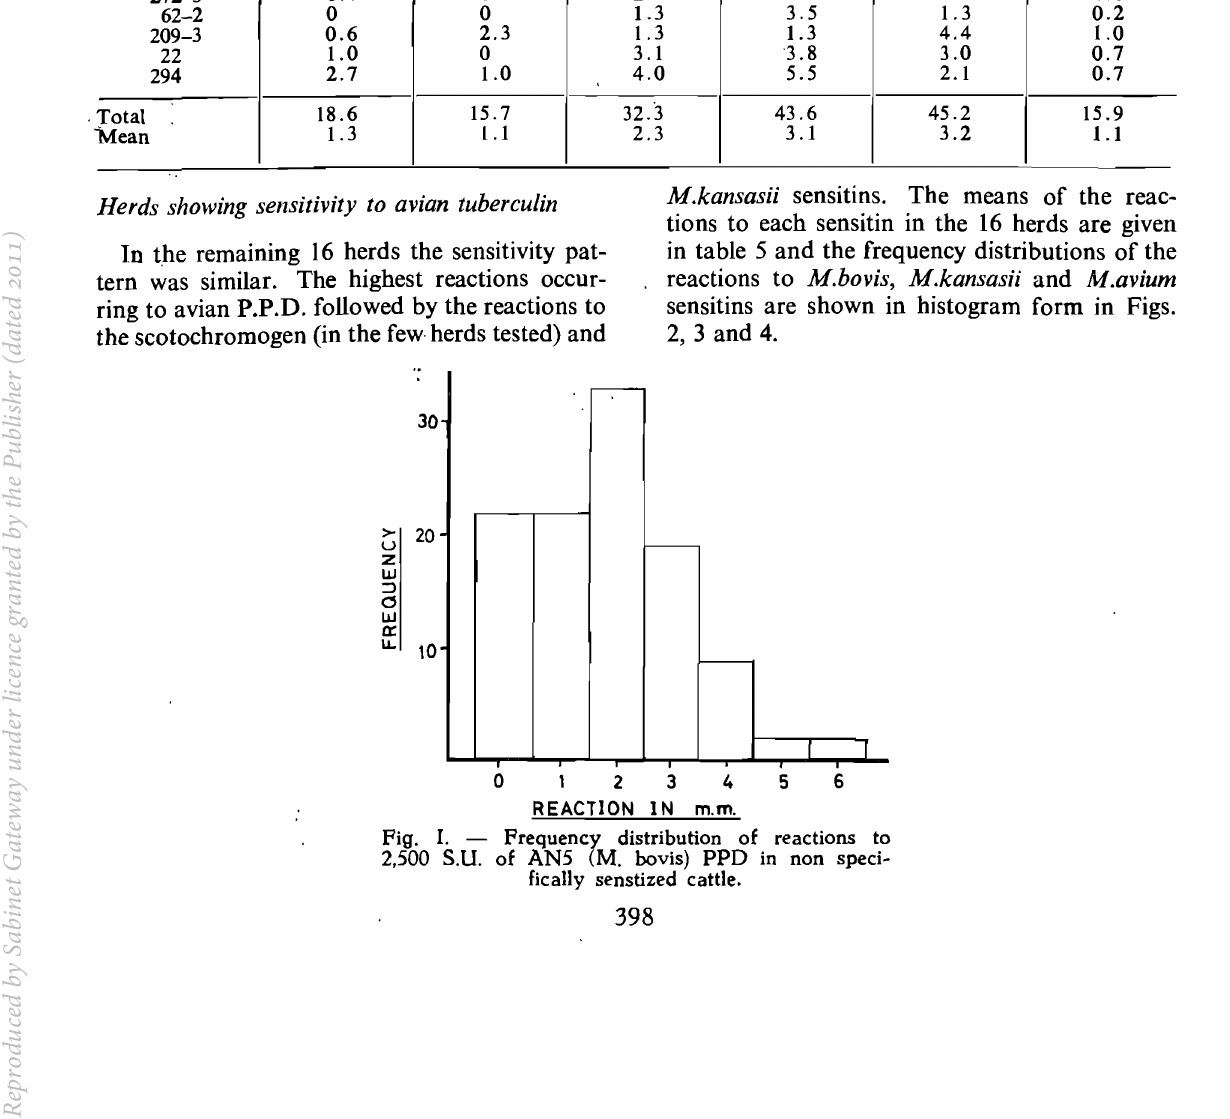
Frequency distribution of reactions to 2,500 S.U. of AN5 (M. bovis) PPD in non speci fically senstized cattle.